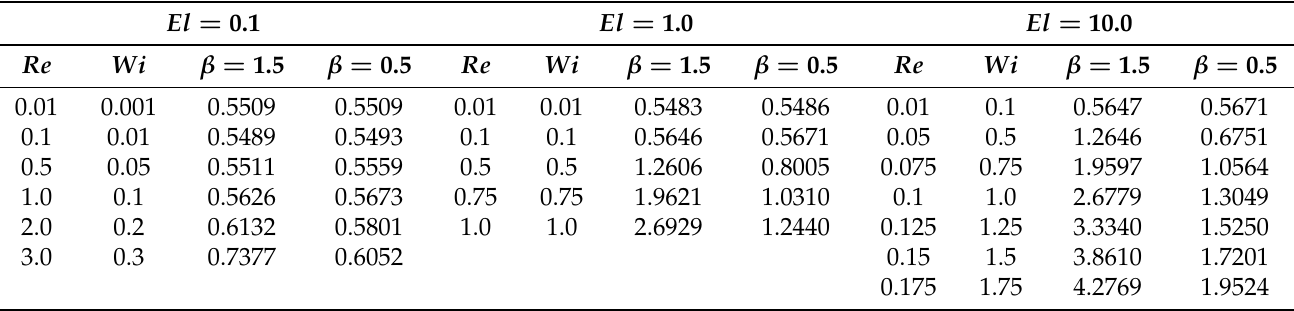
Table 3. Influence of the Elasticity number, El = Wi , α = 1.5. El = 10.0 for L 98%